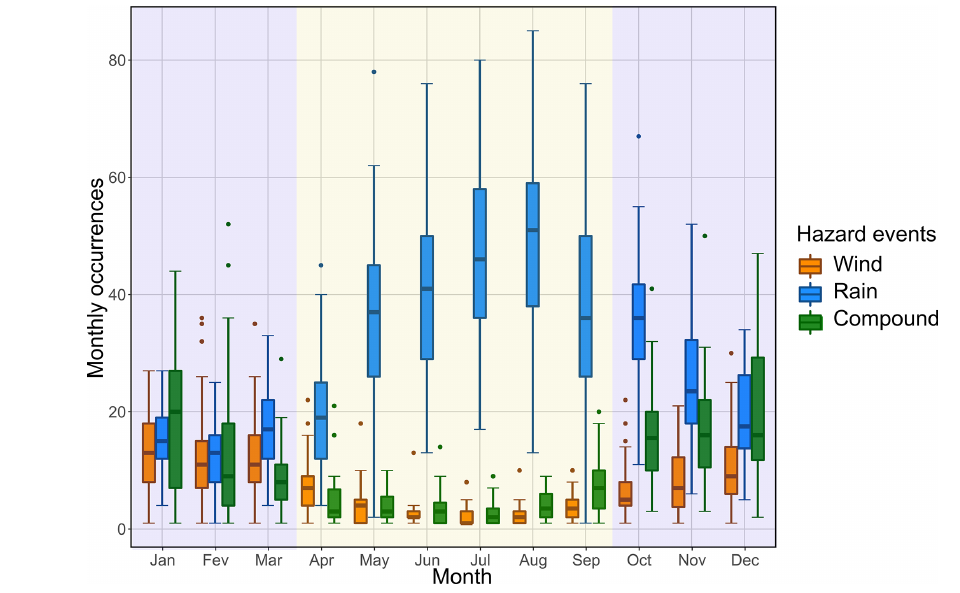
Figure A4. Box plots of the monthly number of wind (dark orange), rain (blue), and compound (green) hazard clusters in Great Britain over the period 1979–2019. Background colours represent the two seasons. Data from ERA5 (Hersbach et al., 2018).